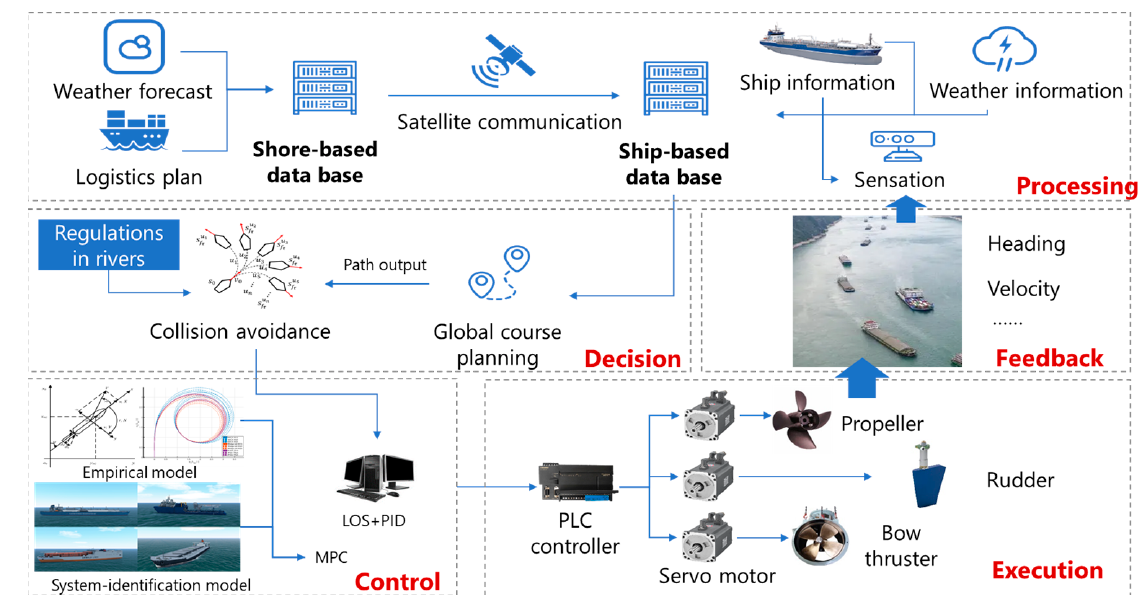
Figure 2. Ship Control Architecture.